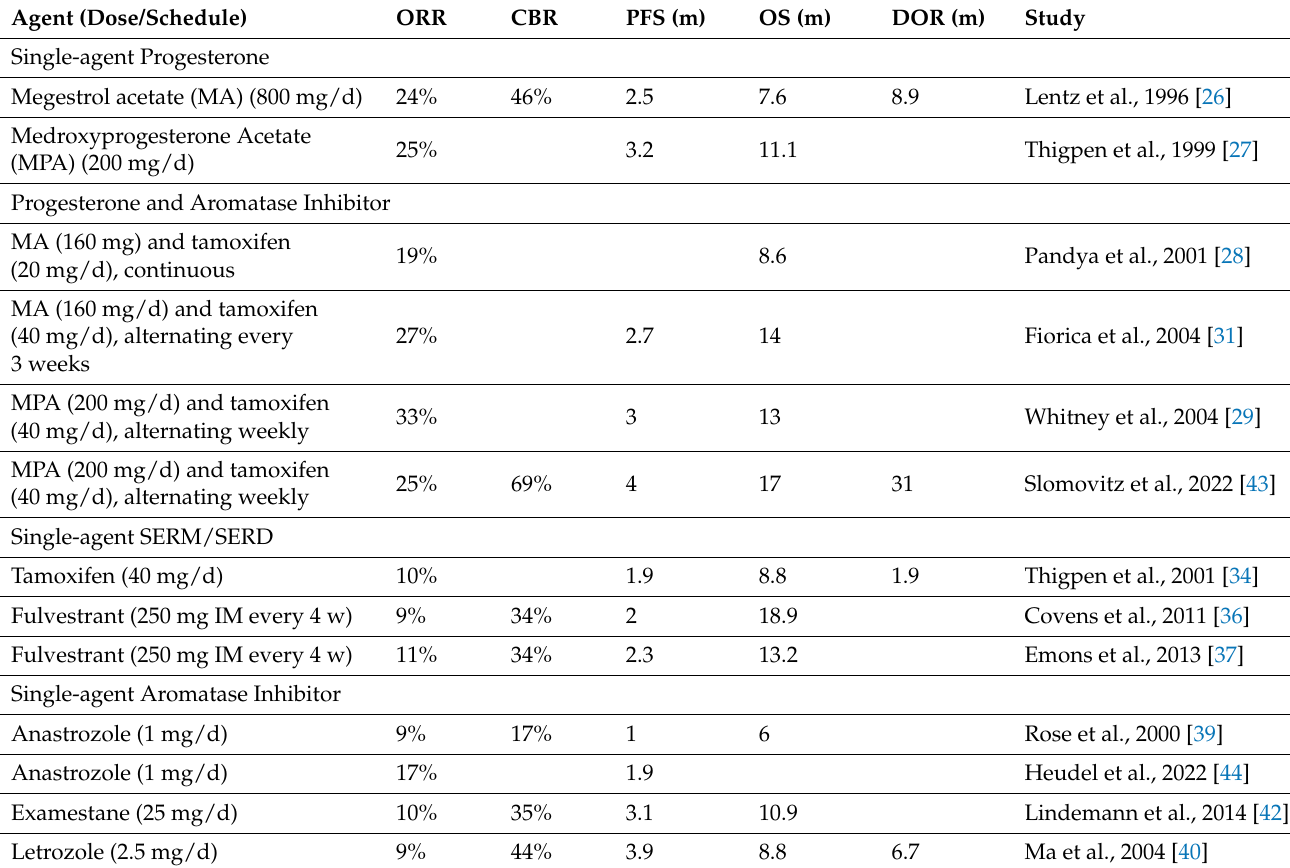
Table 1. Hormonal therapy options with efficacy